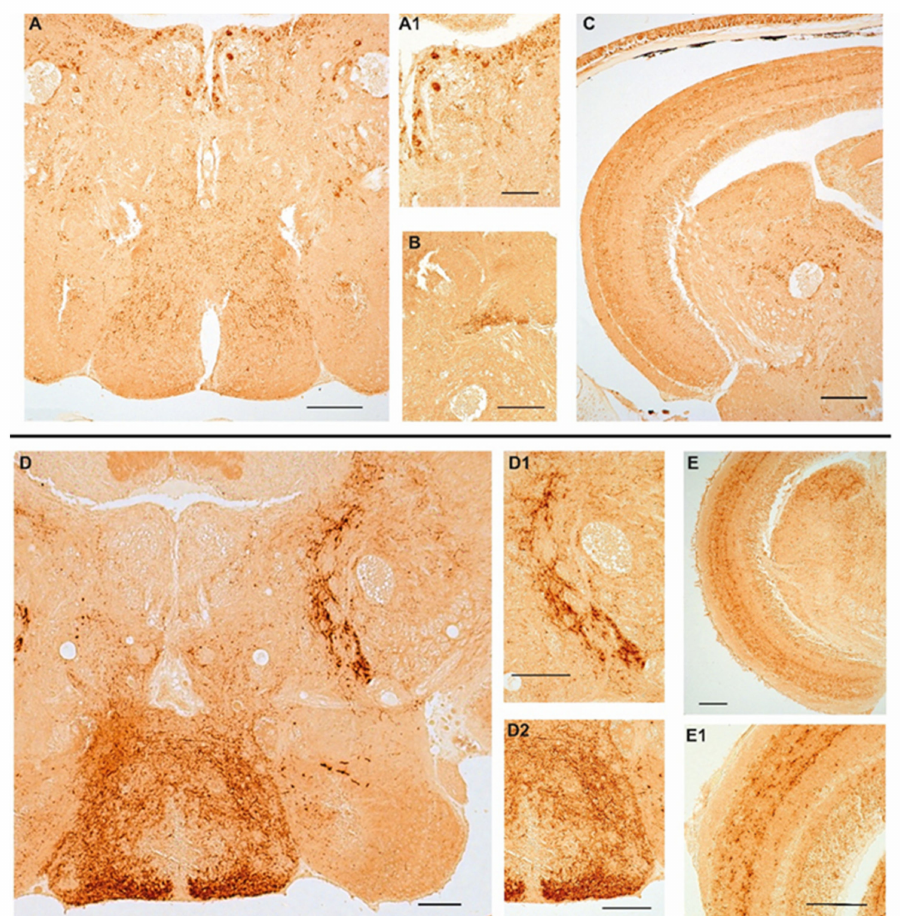
Figure 2. Age-related changes of NPY immunoreactivity in the brain of zebrafish. ( A – C ) Trans- verse sections of the brain of a 6-month-old zebrafish. ( A ) Overview of NPY immunoreactivity in the hypothalamic area (lateral and dorsal periventricular hypothalamus) and in the midbrain tegmentum of 6-month-old zebrafish. Positive neurons are distributed in the lateral hypothalamus, in the proximity of the preglomerular nucleus and along the ventricle. Abundant varicosities are distributed in the hypothalamus and over the entire tegmentum. ( A1 ) Higher magnification of NPY positive neurons along the ventricle and in the proximity of the preglomerular nucleus. ( B ) Packed immunoreactive varicose fibers in the semicircular tori. ( C ) Overview of the optic tectum and the midbrain tegmentum displaying staining in a few neurons of the periventricular grey zone and in varicose fibers over the different layers of the optic tectum, numerous positive neurons along the ventricle and in the proximity of the preglomerular nucleus. ( D – E1 ) Transverse sections of the brain of a 36-month-old zebrafish. ( D ) Overview of NPY immunoreactivity in the hypothalamic area (lateral and dorsal periventricular hypothalamus) and in the midbrain tegmentum of 36-month-old zebrafish. Few intensely immunostained neurons localized in the lateral and dorsal hypothalamus. Strong immunoreactivity in abundant varicosities distributed in the hypothalamus and projecting fibers toward the optic tectum and over the entire tegmentum. ( D1 ) Higher magnification of projecting fibers toward the optic tectum. ( D2 ) Higher magnification of abundant varicosities distributed in the hypothalamus. ( E ) Overview of NPY immunoreactivity in fibers in the optic tectum and in varicosities and neurons in the tegmentum. ( E1 ) NPY immunostaining in the optic tectum layers (asterisks) and in a few cells of the periventricular grey zone. Scale bars 100 µ